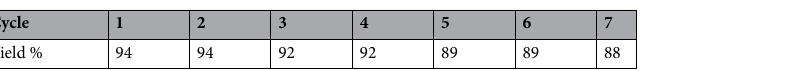
Table 6. Recyclability of synthesized Fe 3 O 4 @UiO@DAS for synthesis 2-amino-3-cyano-4H-chromene via condensation of benzaldehydes (1a), malononitrile (2) and 4-hydroxy-6-methyl-2 H -pyran-2-one (3) in the presence of Fe 3 O 4